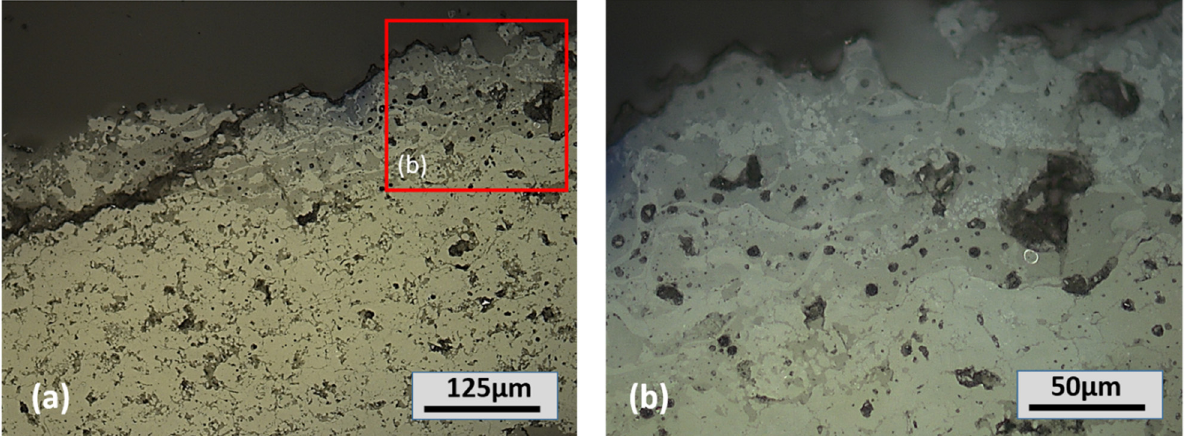
Figure 13. Microstructures of the tri-phase (t’+c+YAG) TBC specimens after CMAS attack tests at 1250 °C for 5 h: ( a ) coating attacked by CMAS in the near-surface area; ( b ) a close look on the CMAS-attacked area.